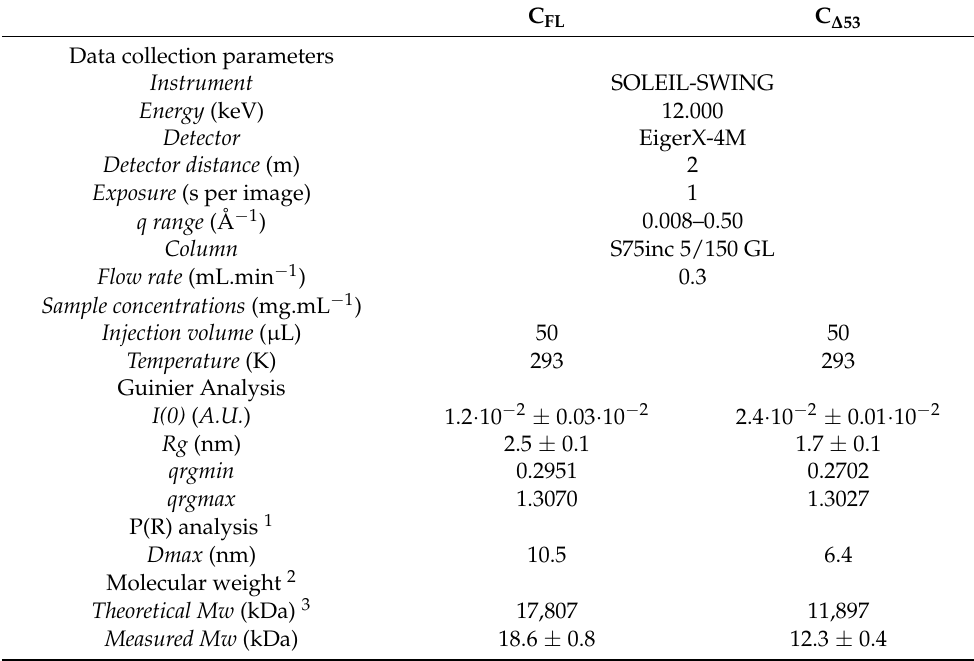
Figure 6. SEC MALLS experiments at different TupV C D53 protein concentrations. 50 mL of protein solution were injected onto a Superdex 75 column at different initial concentrations: 3.3 mg.mL − 1 in dark red, 8.5 mg.mL − 1 in red, 8.8 mg.mL − 1 in blue, 20.0 mg.mL − 1 in dark blue and 23.5 mg.mL − 1 in black. The lines show the chromatograms monitored by refractive index and the crosses show the molecular masses calculated at each time from the light scattering intensity and refractive index. Numbers show the calculated weight average molecular masses (M w ). Table 2. Small-angle X-ray Scattering Data Collection and